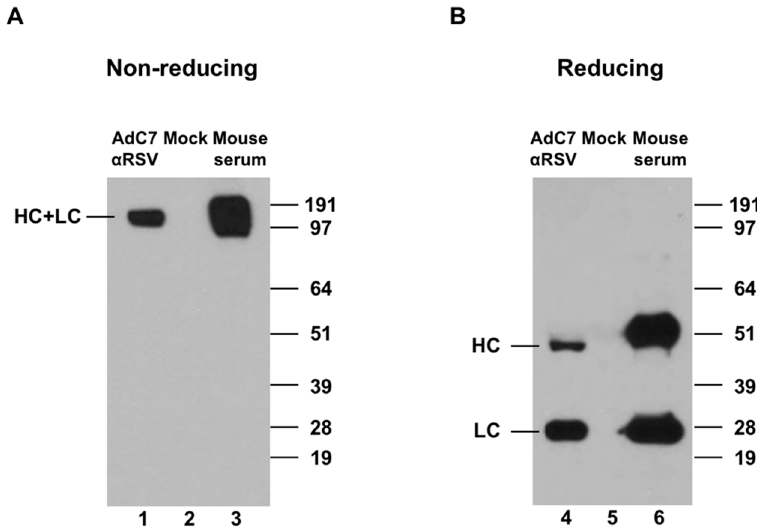
Figure 2. Expression of murine anti-respiratory syncytial virus (anti-RSV) IgG in vitro. Anti-RSV IgG in supernatants of A549 cells infected with chimpanzee adenovirus type 7 vector expressing murine anti-RSV IgG (AdC7 α RSV) was detected by Western Blot analysis. ( A ) Expression of the full-length murine IgG under non-reducing conditions. ( B ) Expression of the heavy chain (HC) and light chain (LC) of murine IgG under reducing conditions. The supernatant of mock-infected cells was used as a negative control (lanes 2, 5). Mouse serum 8 weeks post infection with RSV was used as a positive control (lanes 3, 6). Detection was with a horseradish peroxidase (HRP)-conjugated sheep anti-mouse IgG and HRP chemiluminescence substrate.